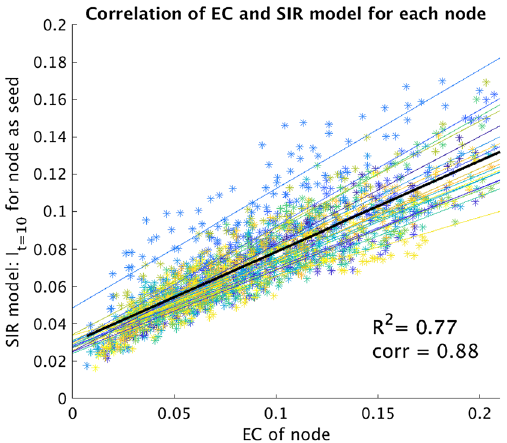
Figure 7. Correlation of the nodal EC with the SIR model for all patients. The EC was calculated for each of the 92 nodes in the structural network. For the SIR model, each node was activated separately at the start (only one seed) and the number of active nodes at time 10 (I t=10 ) was averaged over 10,000 runs. The correlation was measured independently for each patient (thin coloured lines); on average the Pearson’s correlation coefficient was 0.95 ± 0.02. When considering all data points together, the correlation decreased to 0.88 but was still